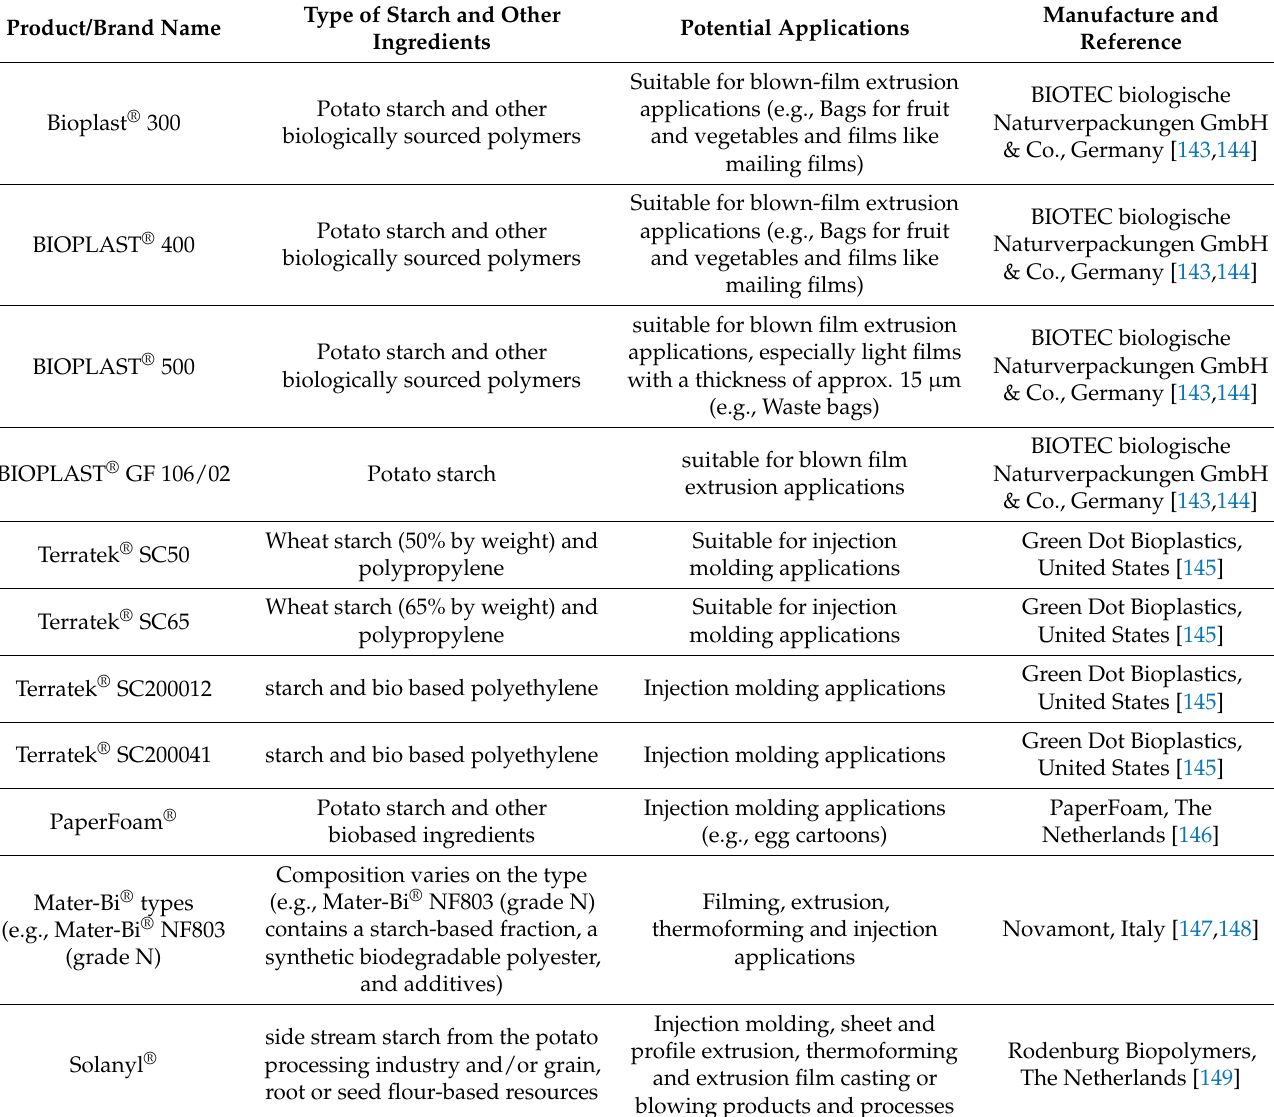
Table 3. Examples of market available starch-based packaging